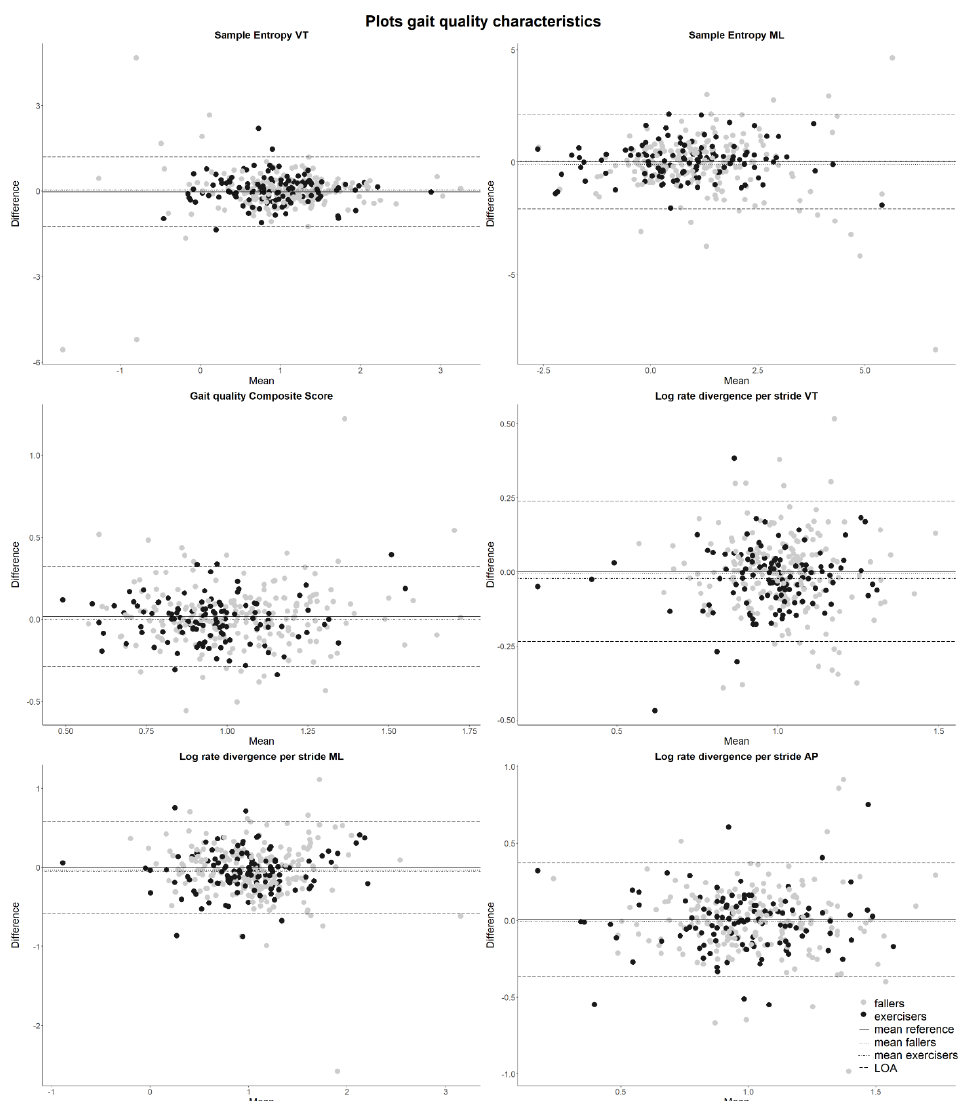
Figure 3. Bland – Altman plots of gait quality characteristics adjusted for walking speed with LOA. Positive differences in sample entropy in ML and gait quality composite and negative differences in sample entropy in VT or logarithmic rate of divergence in VT, ML, or AP indicate an increase in gait quality over one year. The continuous line is the mean change in the reference group. Long dashed lines are the LOA determined in the reference group. The dotted line (mean change in the fallers) and dot-dashed line (mean change in the exercisers) are sometimes overlapping the continuous line (mean change in the reference